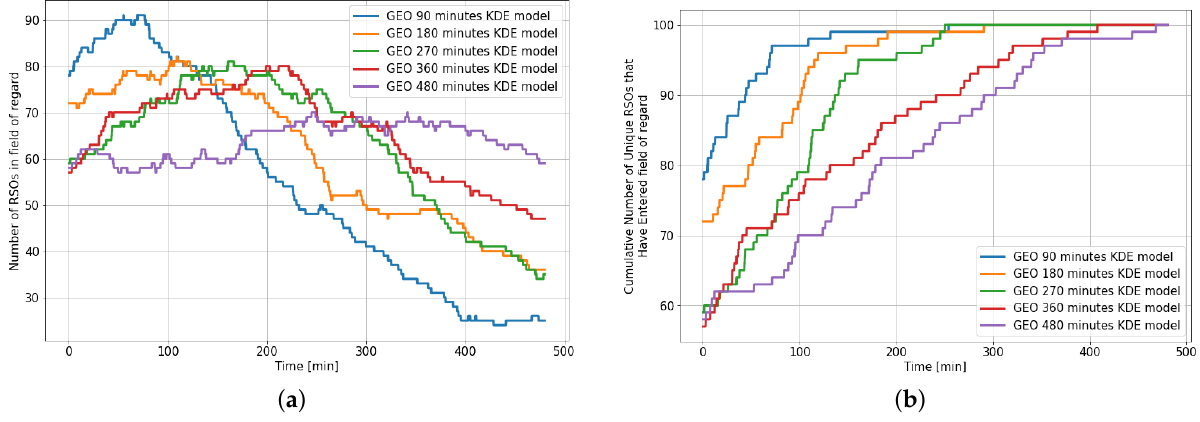
Figure 12. Statistics of RSOs within the field of regard over an 8 h observation window for 100 RSOs using different GEO KDE models. ( a ) Number of RSOs within the field of regard; ( b ) Cumulative number of unique RSOs within the field of